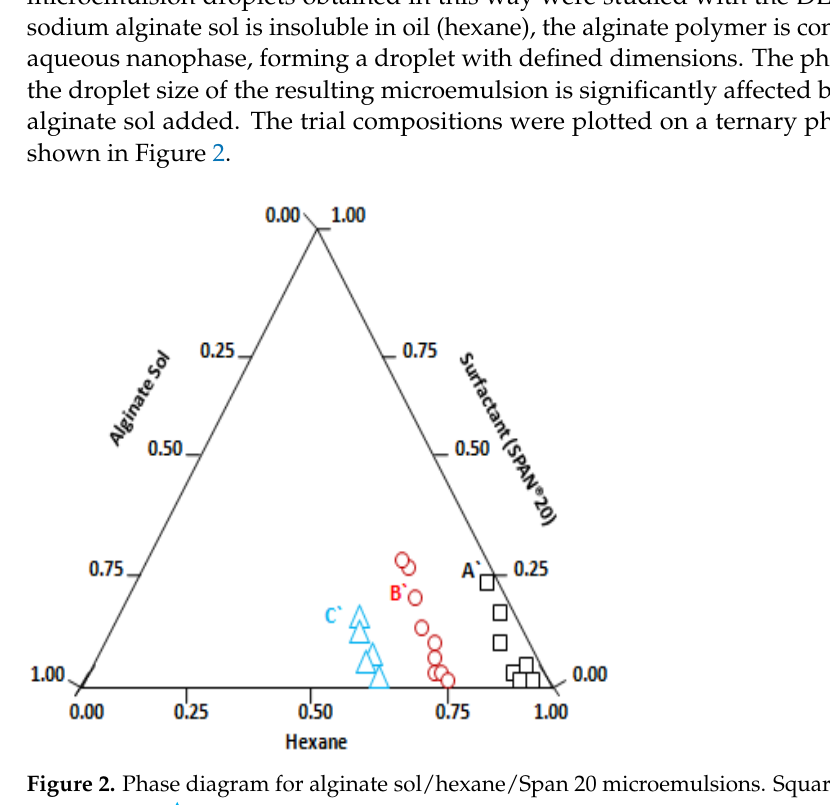
Figure 3. W/O microemulsion of Span 20, representing points ( A` ) (clear microemulsion), ( B` ) (slightly turbid microemulsion) and ( C` ) (milky appearance microemulsion). For all systems studied, droplet size increases as the amount of aqueous phase in- creases. Thus, at the concentration of dispersed phase (alginate solution), showing droplet size 140 nm, the swollen reverse micelles were chosen as a template for the nanogel